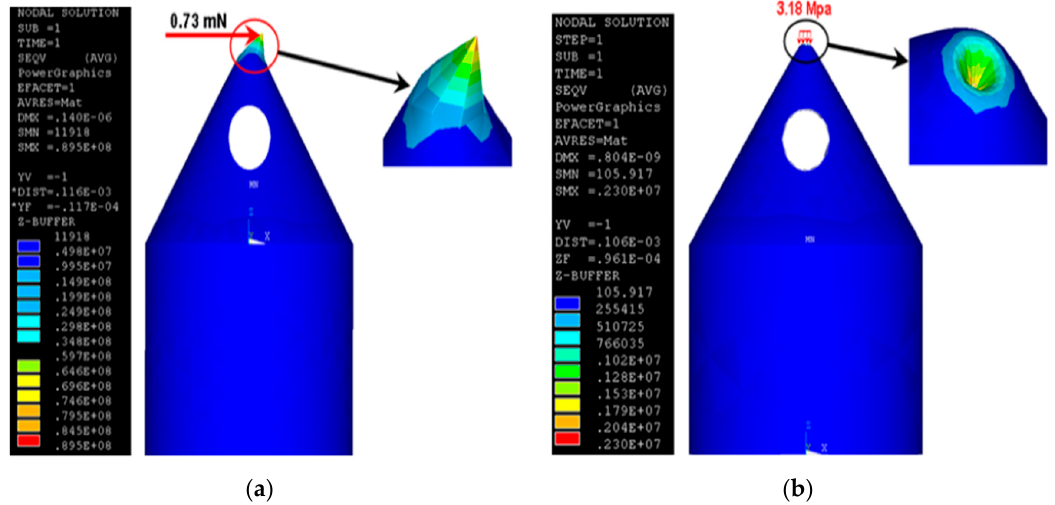
Figure 15. ( a ) Bending stress analysis and ( b ) axial stress analysis (adopted from [109]). The hollow MNs have channels that can continuously deliver drug solution into the skin.